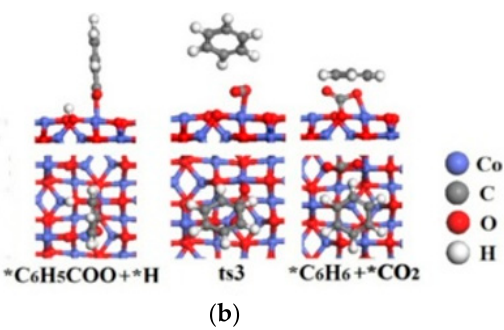
Figure 4. The potential energy diagrams (Red line: C 6 H 5 COOH(g) → *C 6 H 5 COO + *H → *CO 2 + *C 6 H 6 → CO 2 (g) + C 6 H 6 (g); Black line: C 6 H 5 COOH(g) → *C 6 H 5 COO + *H → *C 6 H 5 + *CO 2 + *H → *CO 2 + *C 6 H 6 → CO 2 (g) + C 6 H 6 (g)) and corresponding IS, TS and FS geometrical structures of C 6 H 5 COOH catalytic pyrolysis on Co 3 O 4 (110)-B surface( a ) related to black line; ( b ) related to red line.